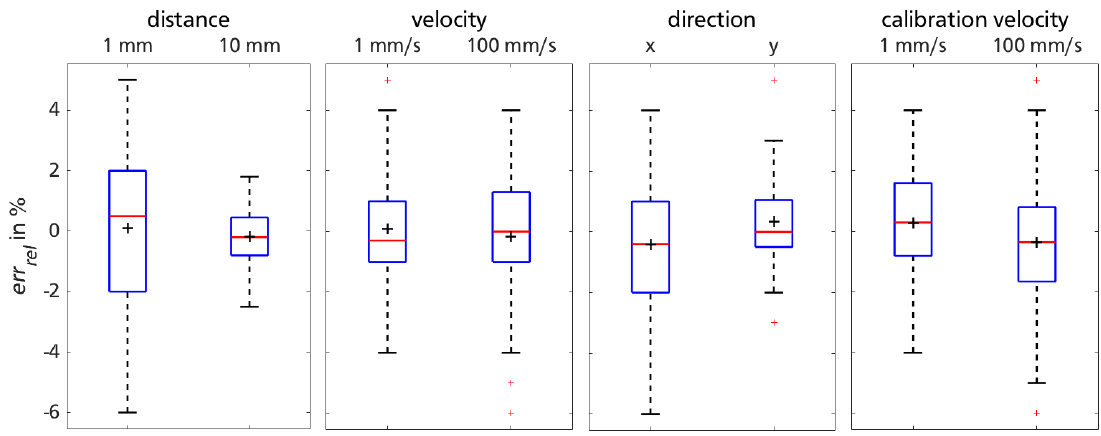
Figure 5. Sensor performance on material 5 for favorable high sensor sensitivity, grouped for remaining measurement factors of trial session